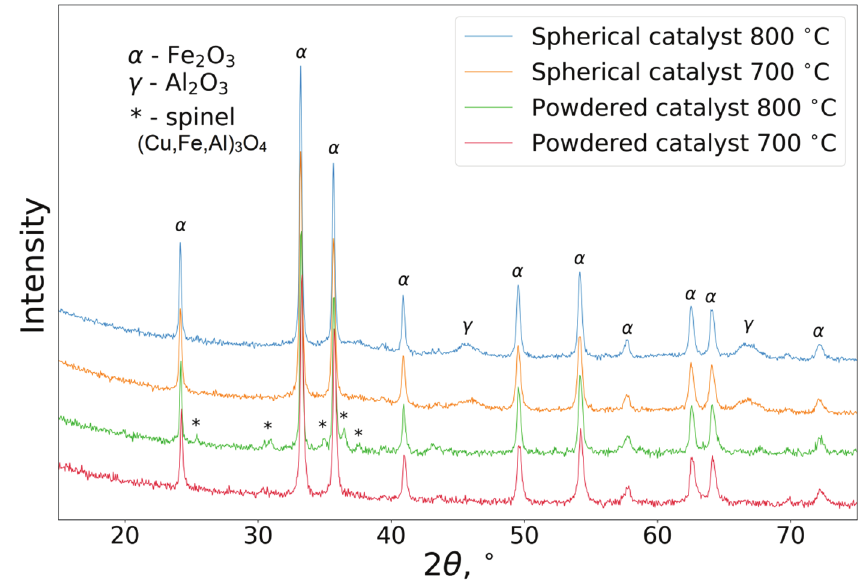
Figure 5. XRD patterns of CuFeAl catalysts.